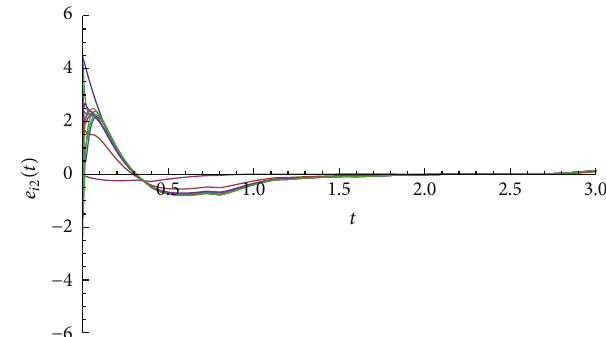
Figure 3: The decline curve of 𝜆 max ((𝐺 𝑠 ) 𝑙 ) with the number of pinned nodes.